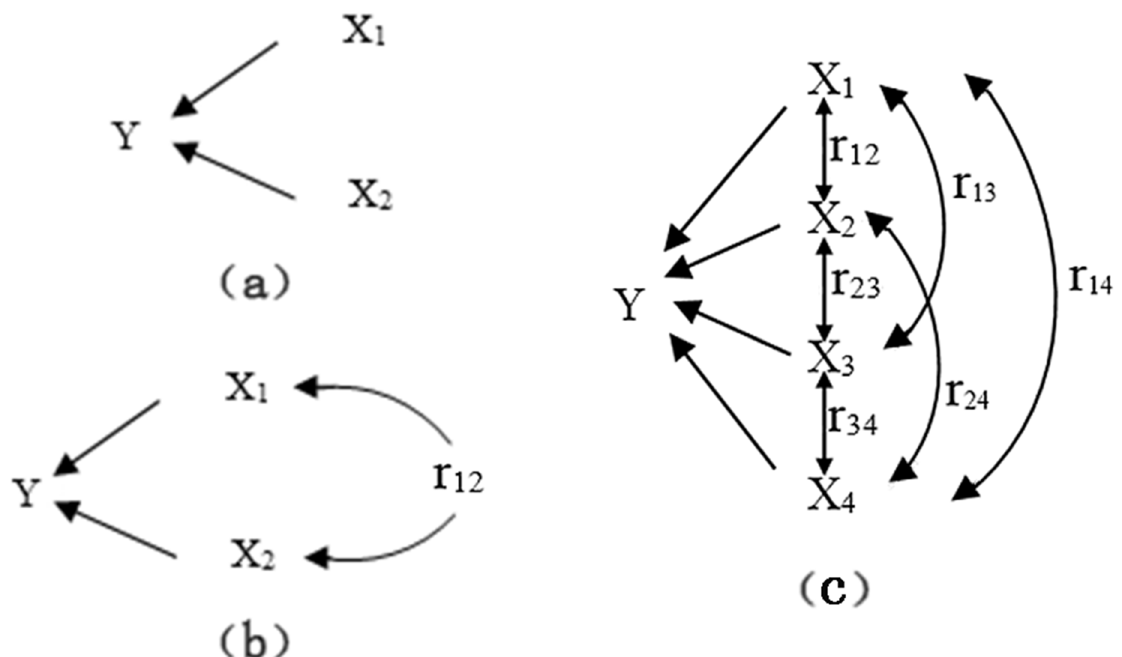
Fig 4. Network to explanation path analysis between independent variables (X i ) and dependent variable(Y). X 1 -VFA; X 2 -TAN; X 3 - total alkalinity; X 4 -